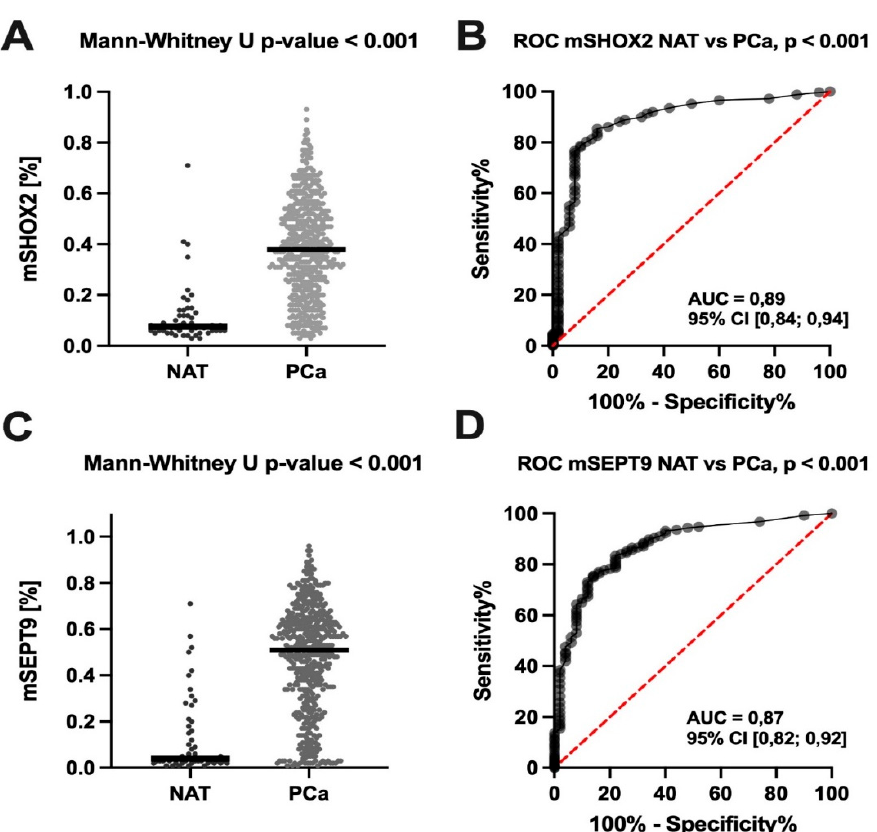
Figure 1. ROC curve analysis of mSHOX2 and mSEPT9 comparing healthy and primary PCa tissue samples. ( A , C ) show quantitative differences of mSHOX2 (methylated short stature homeobox 2) and mSEPT9 (methylated Septin 9) in NAT (normal adjacent tissue, (n = 50)) and PCa (primary prostate cancer (n = 498)). ( B , D ) illustrate the corresponding AUC (area under the curve) by ROC (Receiver operating characteristic) curve analysis, respectively.